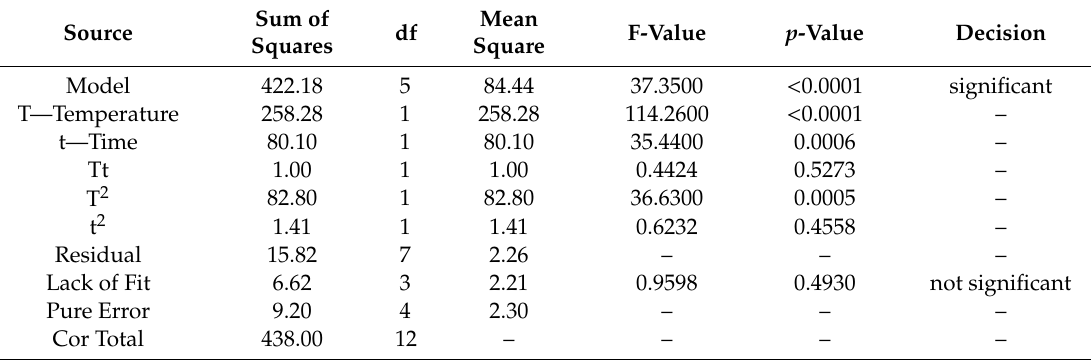
Table 2. ANOVA for the quadratic model of fixed carbon content.